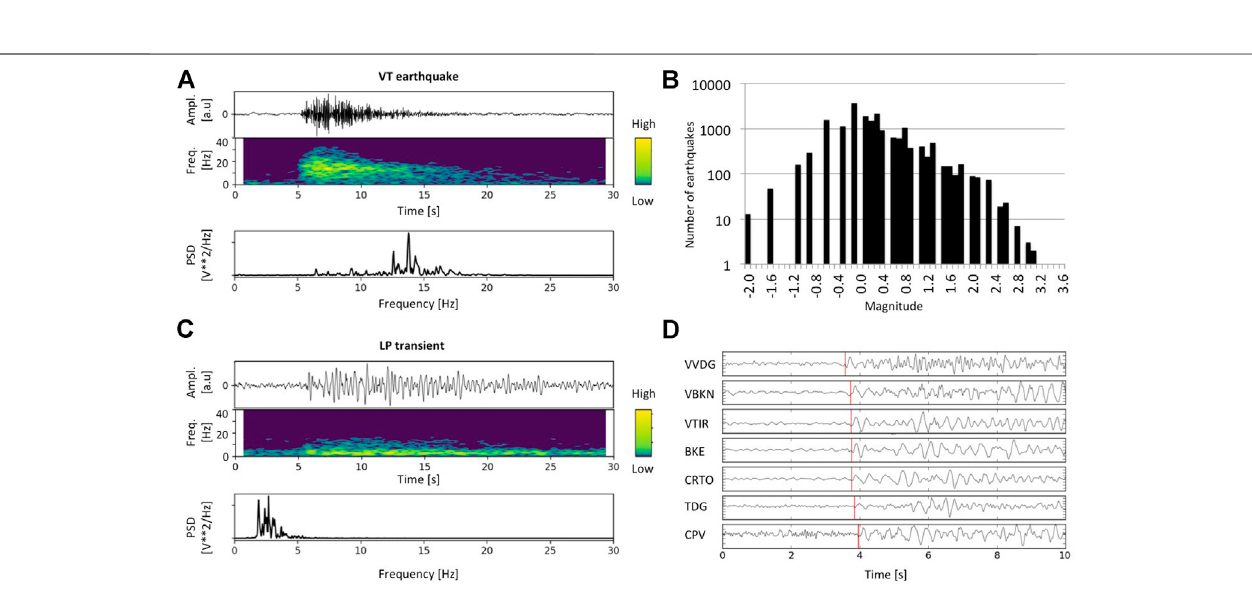
FIGURE10|(A) Seismogram,spectrogramandspectrum ofatypicalVesuvianVTearthquakerecordedonNovember 29,2020 at5:16am. (B) Distribution ofthe magnitude oftheearthquakesrecorded bytheBKE station from 1999to2020(BKE catalog; Logscale onvertical axis). (C) Seismogram,spectrogram and spectrum of theLPtransientrecordedonNovember16,2020 at5:16am. (D) PickingoftheonsetoftheLPtransientrecordedonNovember16,2020at5:59am.Forthepositionof the seismic stations see Figure 1 .